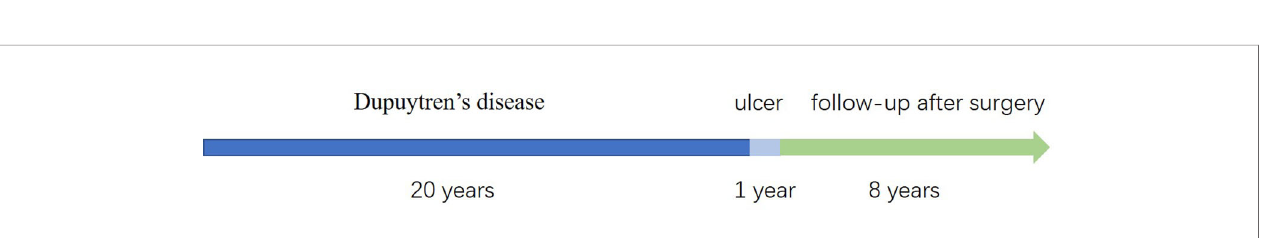
FIGURE 3 | Timeline of the disease ’ s